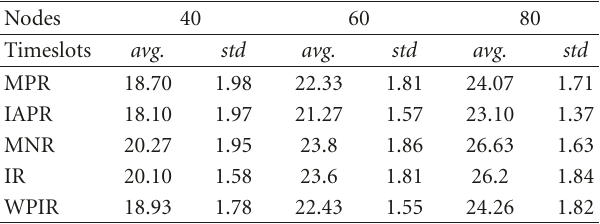
engine can compensate the decisions from the routing engine and thus being able to successfully pack all transmission in almost the same number of timeslots irrespectively of the routing scheme. Despite this fact, the IARP scheme is still very robust to di ff erent topologies. As can be seen from the error bar, which expresses the standard deviation, in Figure 5, the std of the frame length for the IARP scheme is approximately 30% less than that of the MPR scheme. The optimal joint power and routing problem OSR( L ) (defined in Section 3.2) has been solved for a small